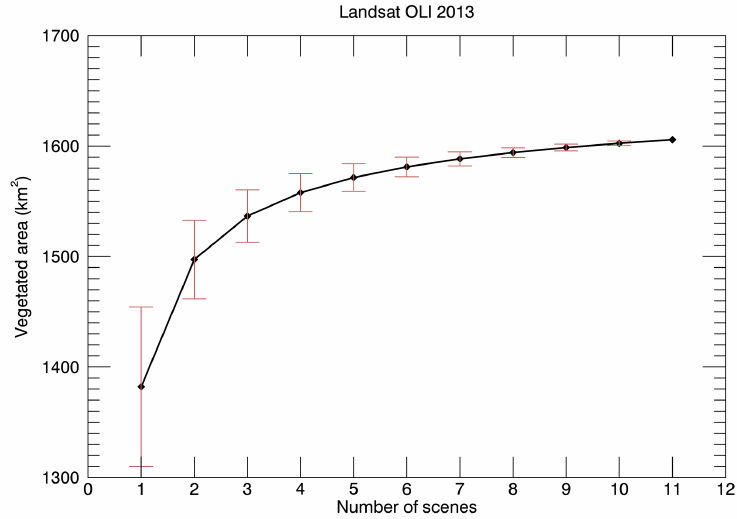
Figure 8. Variation of the area detected as vegetated as a function of the number of images used, considering all the possible combinations of the eleven OLI images available for 2013. Whiskers refer to the standard